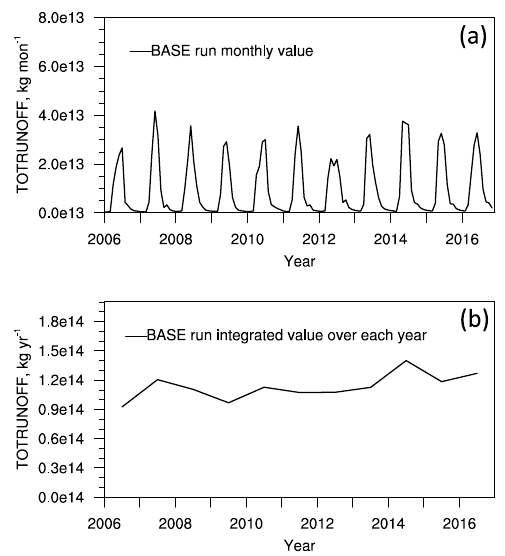
Figure 8. Monthly (a) and annually integrated (b) time series of total runoff from Greenland in the base run without BC